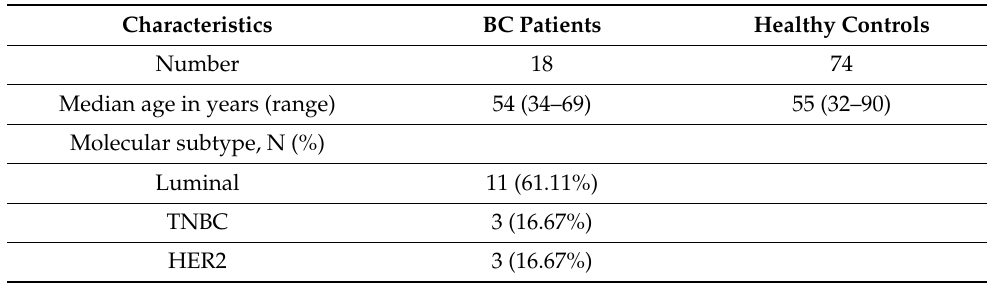
Table 2. Clinicopathological characteristics of stage I BC patients and healthy controls from Cohort